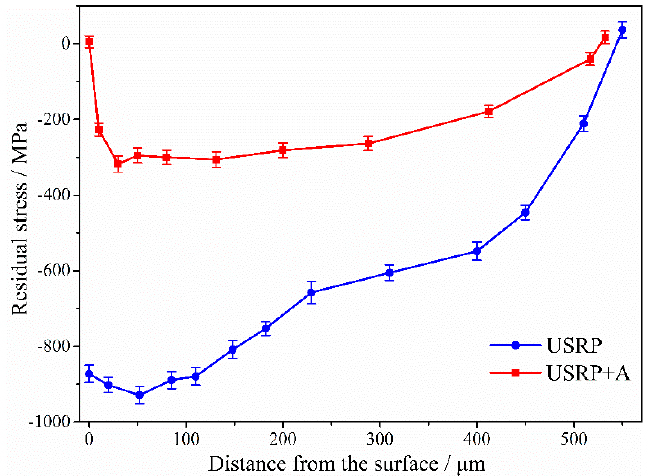
Figure 7. The results of axial residual stress distribution along the cross-section of samples with different treatments.